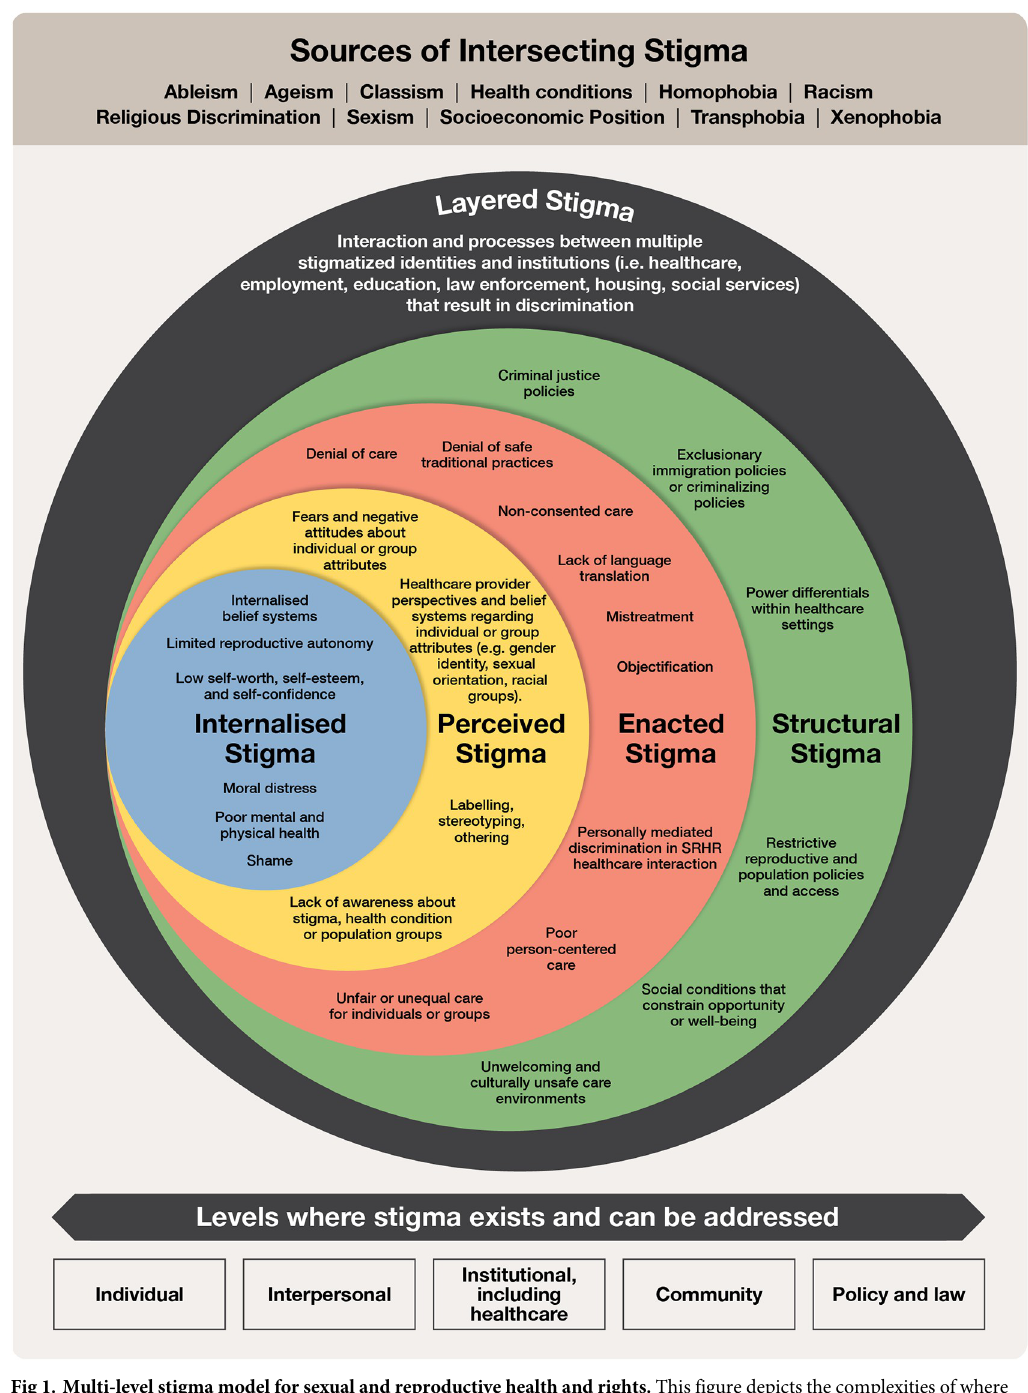
Fig 1. Multi-level stigma model for sexual and reproductive health and rights. This figure depicts the complexities of where stigma and discrimination exist within sexual and reproductive health and rights, and the levels where it can be confronted. Footnote: i Internalized stigma: person with certain attributes is aware of public stigma about their attributes, agrees with these stereotypes, and applies the stigma to themselves [13] ii Perceived stigma: individual’s awareness of public stigma or beliefs that others hold stigmatizing thoughts about a condition [14, 15] iii Enacted stigma: manifestations of unfair treatment arising from adverse social judgment [16] iv Structural stigma: societal conditions, sociocultural norms, and institutional policies that influence the opportunities and well-being of stigmatized groups [17] v Layered stigma: interaction between multiple stigmatized identities within an individual or group [18].